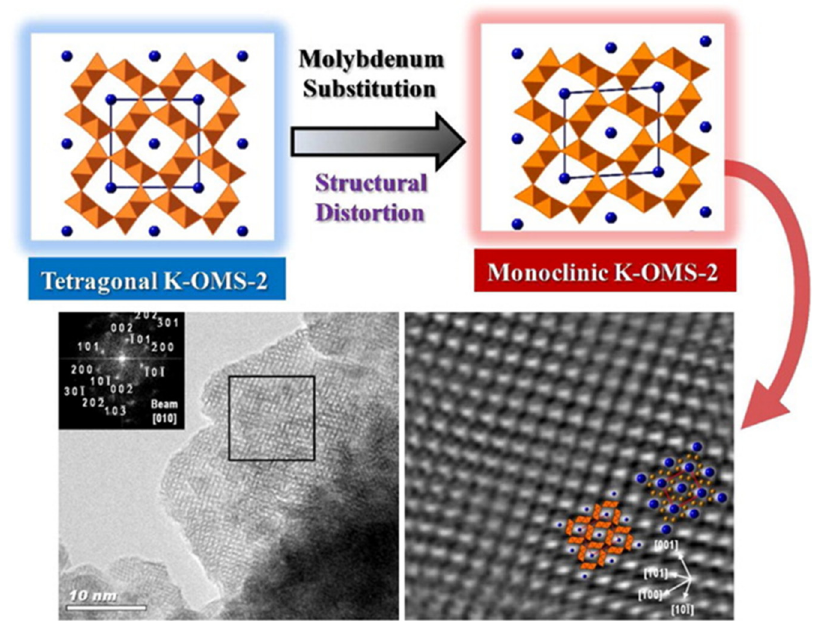
Figure 13. HR-TEM images showing the structural distortion of the original tetragonal K–OMS–2 structure due to the molybdenum substitution. On top, a brief scheme showing this transformation. Image extracted from [151].